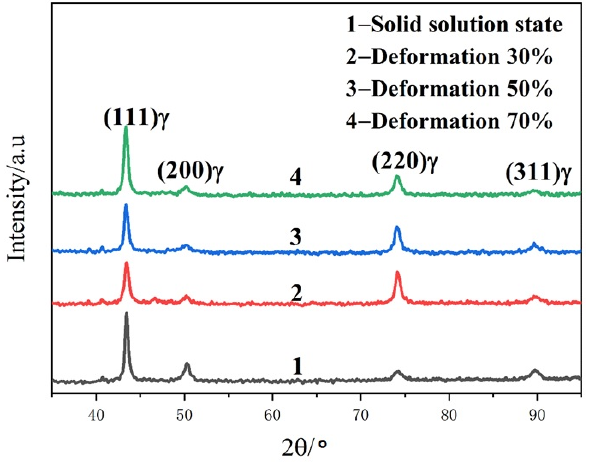
Figure 2. XRD patterns of Fe-25Mn-3Si-3Al-0.3Nb steel before and after cold rolling.